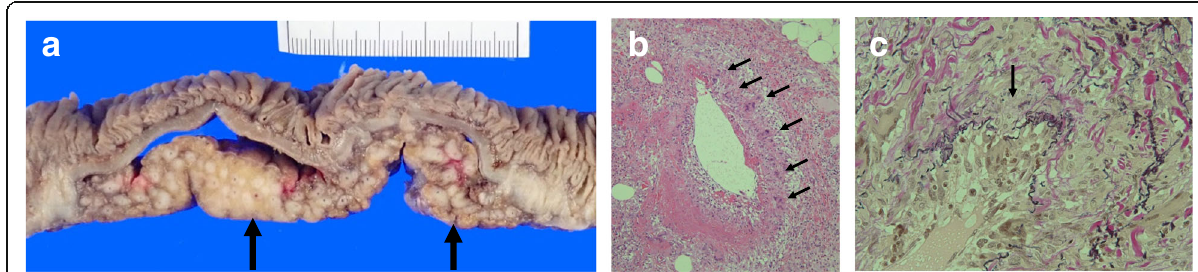
Fig. 2 Histopathological examinations. a Specimen of the resected jejunum and mesentery: The mesentery includes significant nodular thickening (arrow). Each nodule has central canals composed of the vessel. b The arterial wall structure of GCA was broken, and all layers were not clear to distinguish. Hypertrophy of vascular intima is remarkable. Stenosis of the arterial lumen is mildly displayed. Multinucleated giant cells (arrow) are scattered on the endothelium, in the intima, media, and adventitia. Lymphocyte, neutrophils, and eosinophils are also infiltrated. c